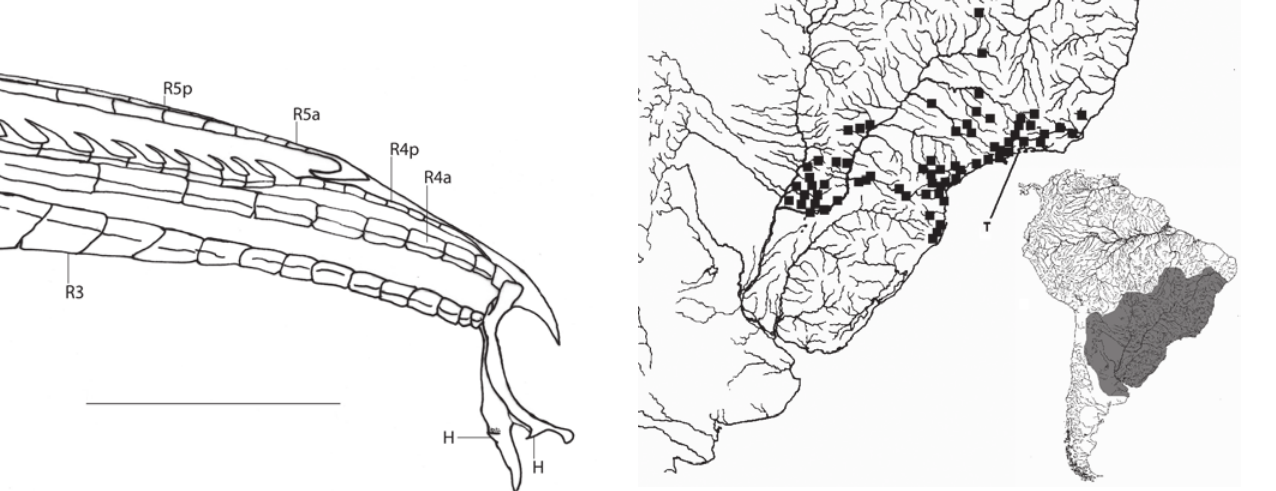
Fig. 29. Collection localities of Phalloceros harpagos . Some symbols represent more than one lot or locality. T represents type locality. The inset is the range of the